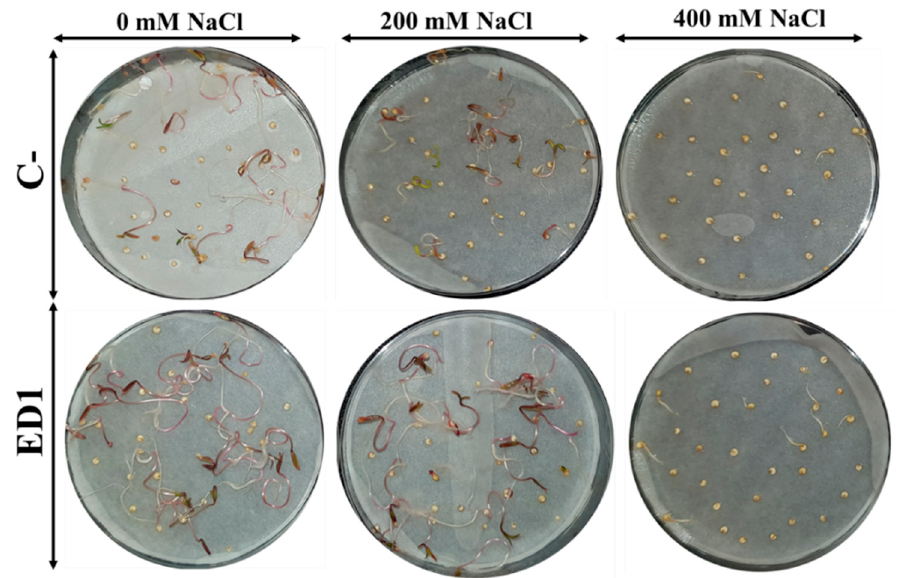
Figure 7. Effect of the Serratia rubidaea ED1 strain on quinoa seed germination and early growth seedlings under saline treatments. Seeds inoculated with phosphate-buffered saline (PBS) were used as a negative control (C − ).